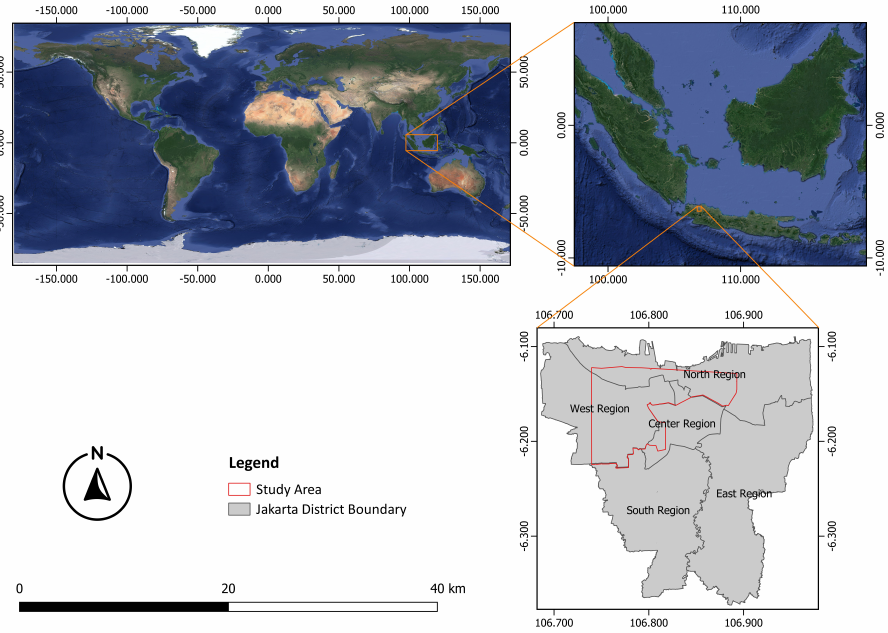
Figure 1. Maps of Jakarta’s location with respective regional administrative boundaries and selected study